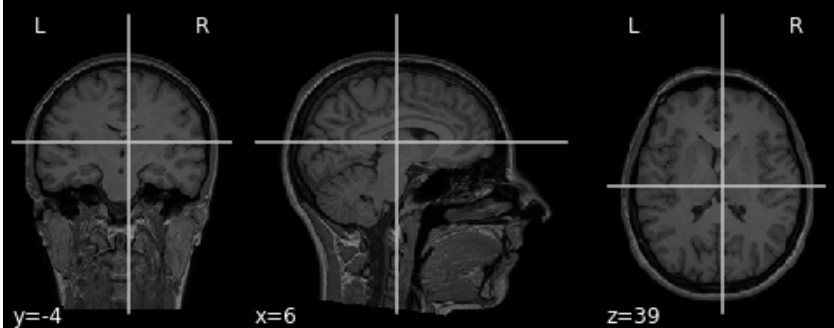
Figure 3. Axial MRI sample of a normal person with healthy